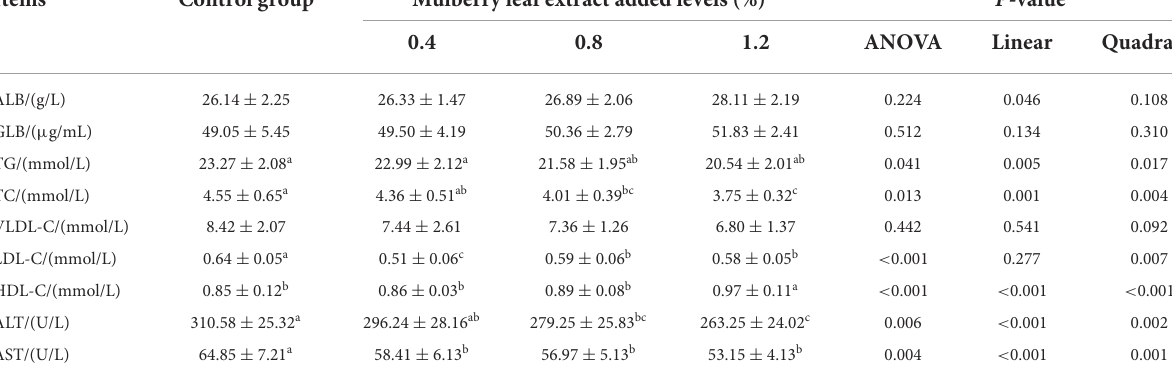
TABLE 3 Effects of mulberry leaf extract on serum biochemical indices of laying